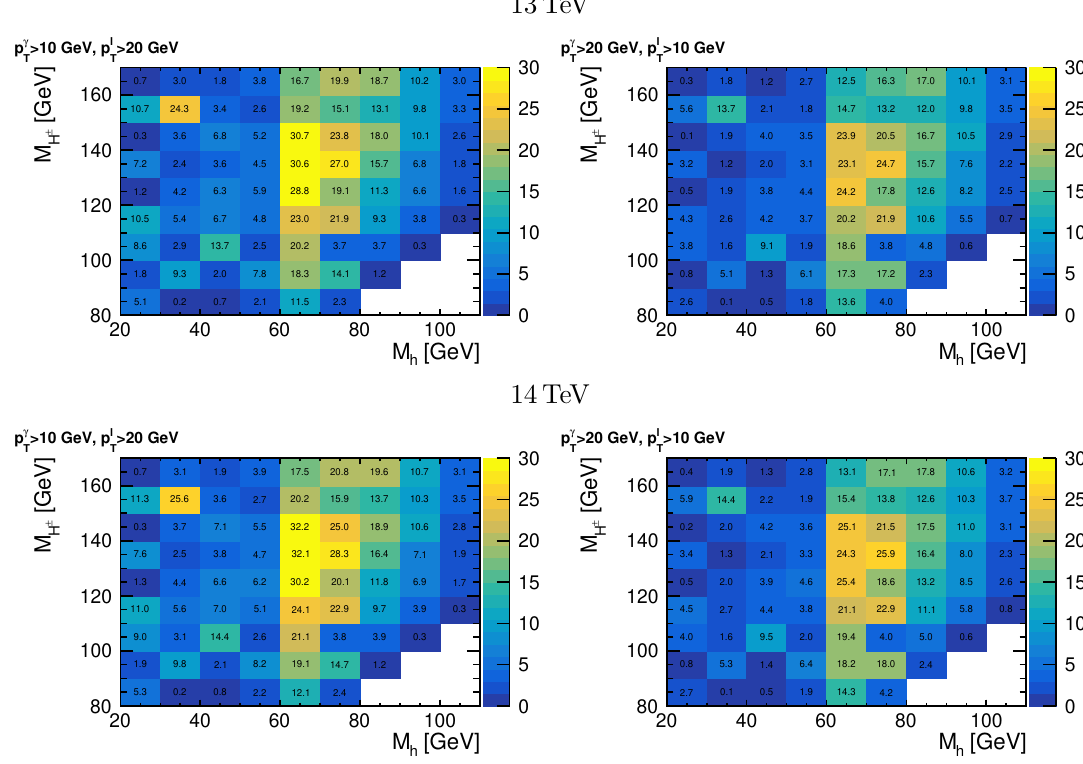
) plane for the two sets of cuts given in H ± √ √ s = 13 TeV (top) as well as s = 14 TeV (bottom) and